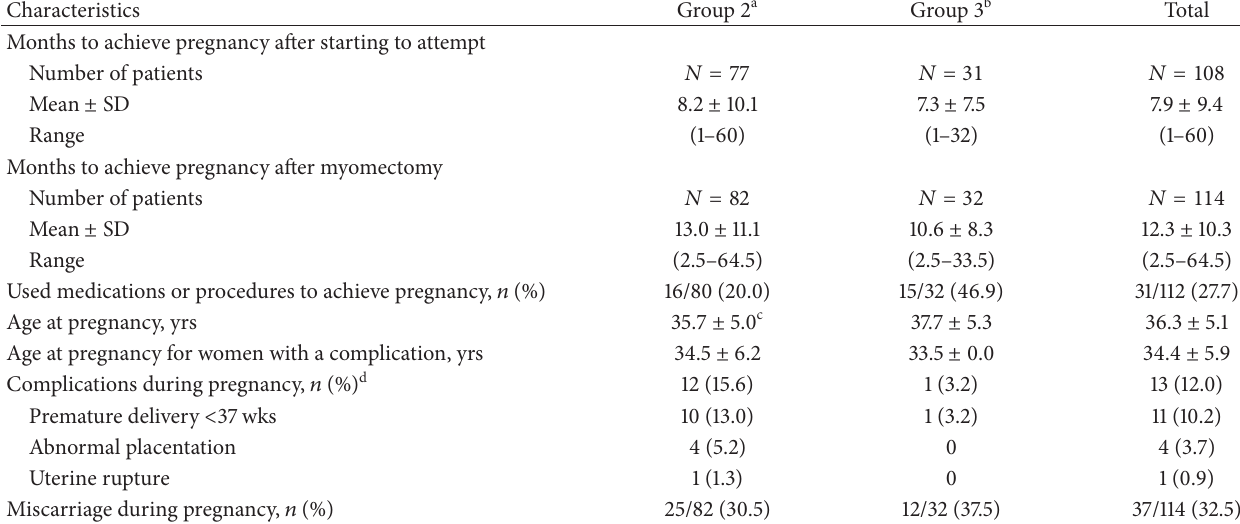
Table 2: Characteristics of women who achieved pregnancy after